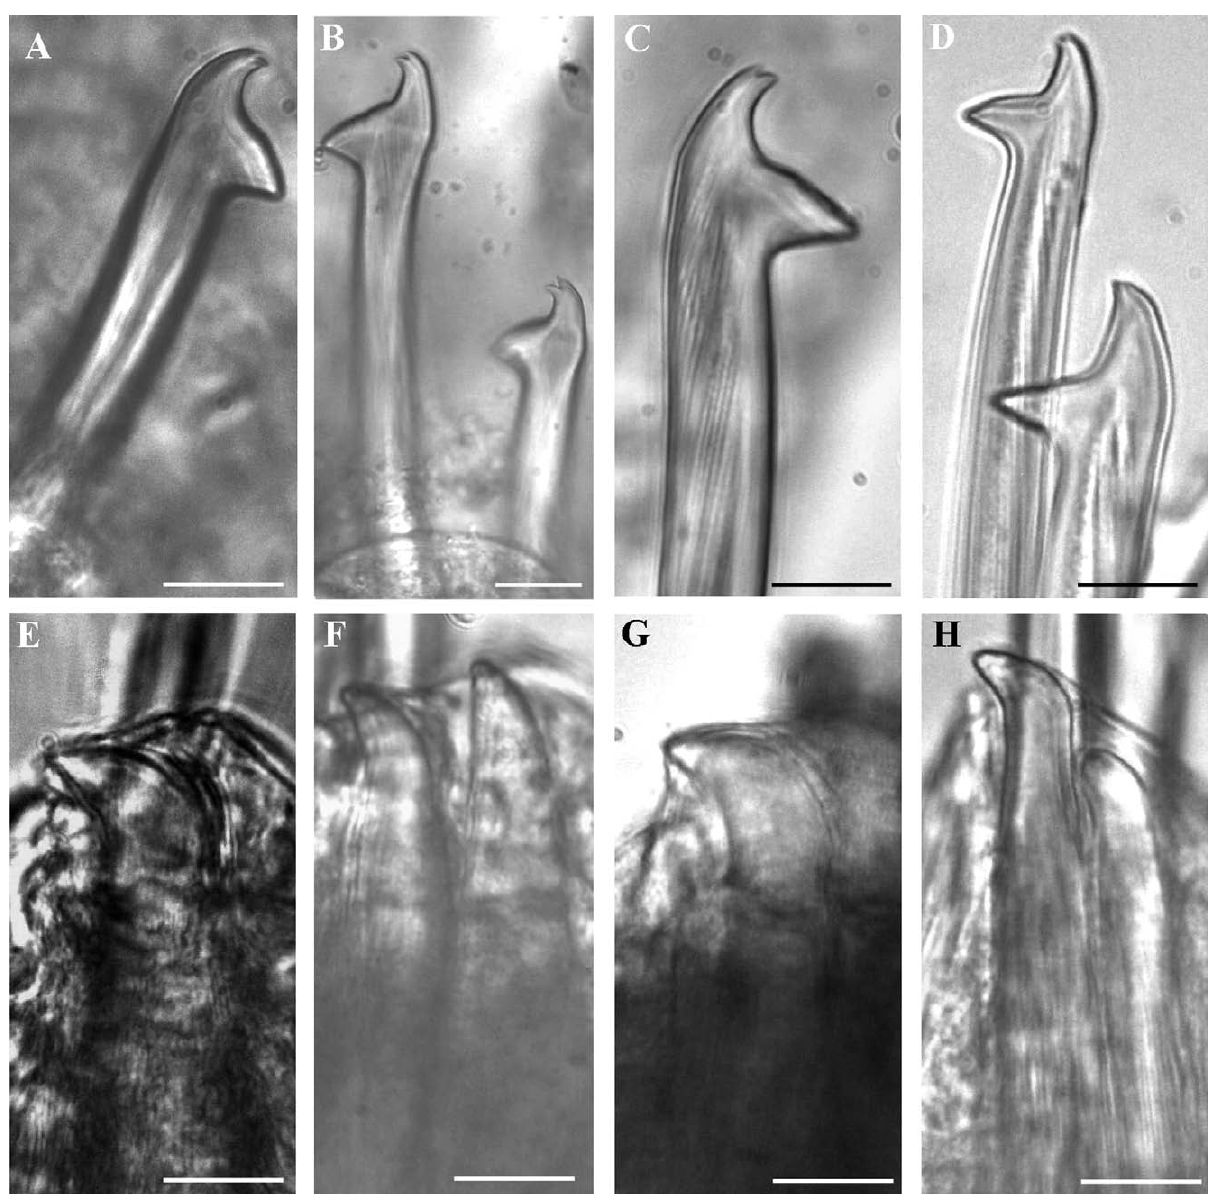
Fig . 8. – Comparative photographs of mid-body chaetae and aciculae of Haplosyllis cephatalata (A, E) (INV−ANE 3461.), Haplosyllis cha­ etafusorata n. sp. (B, F) (INV−ANE 3468), Haplosyllis niphatesicola n. sp. (C, G) (INV−ANE 3464), and Haplosyllis sp. (D, H) (INV−ANE 3466). Scale bars 10 m